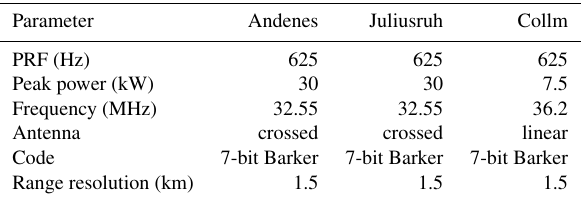
Table 1. Experimental setup for the three meteor radars used in this study. Parameter Andenes Juliusruh Collm PRF (Hz) 625 625 625 Peak power (kW) 30 30 32.55 32.55 36.2 Antenna crossed crossed linear Code 7-bit Barker 7-bit Barker